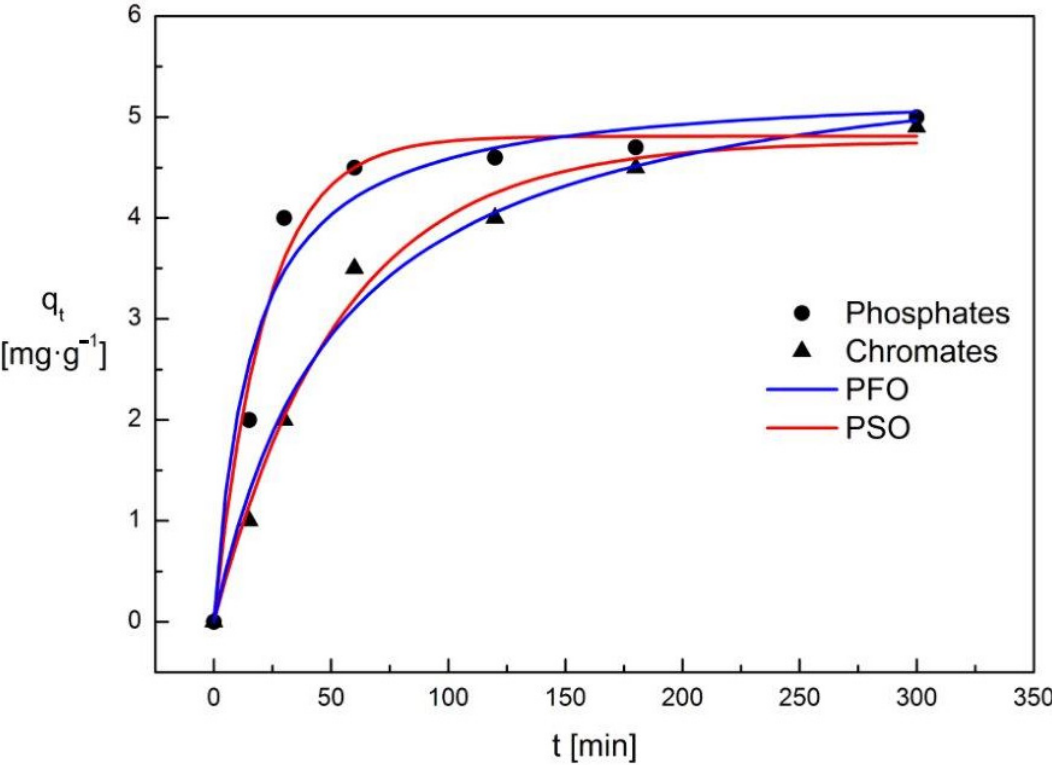
Figure 9. The pseudo-first-order and pseudo-second-order kinetic curves for the adsorption process for chromates and phosphates ions on an Absodan Plus.